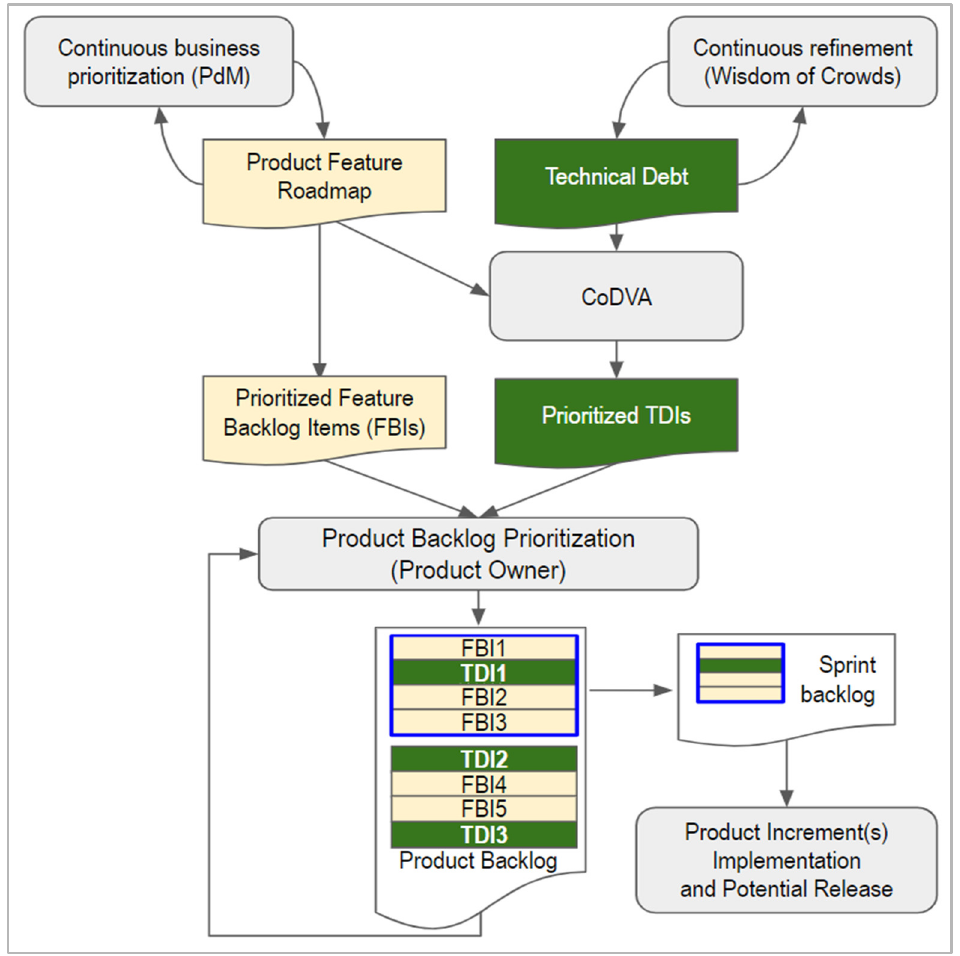
Figure 1. Technical Debt Management Process.